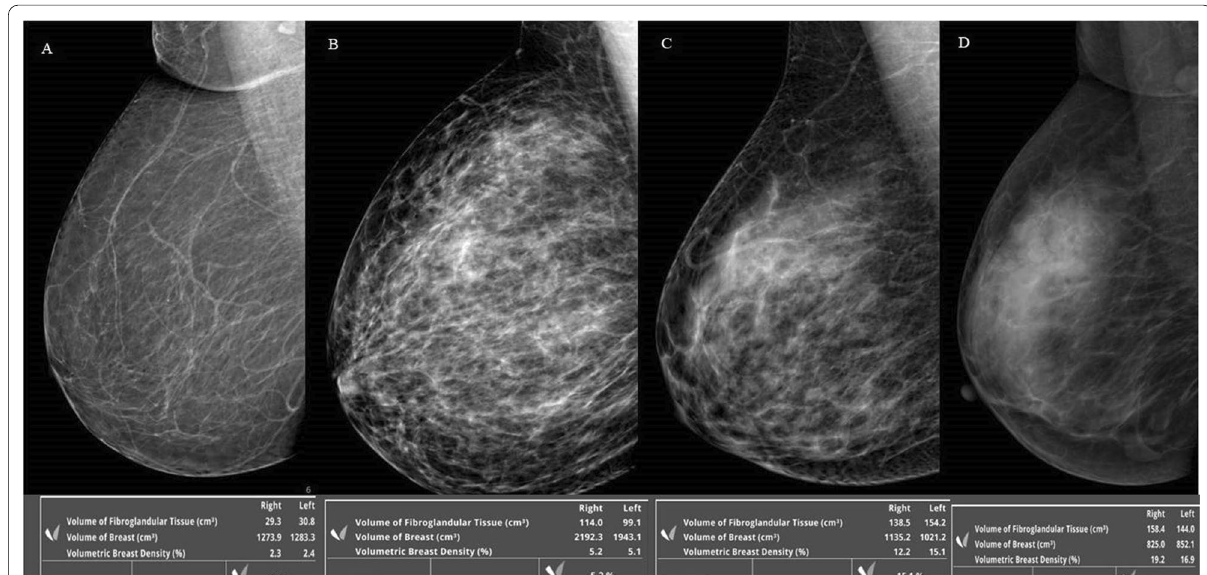
Fig. 1 Medio-lateral oblique views of mammograms of different patients showing volumetric density grades (VDG- A , B , C and D ) with VOLPARA numerical breast density values